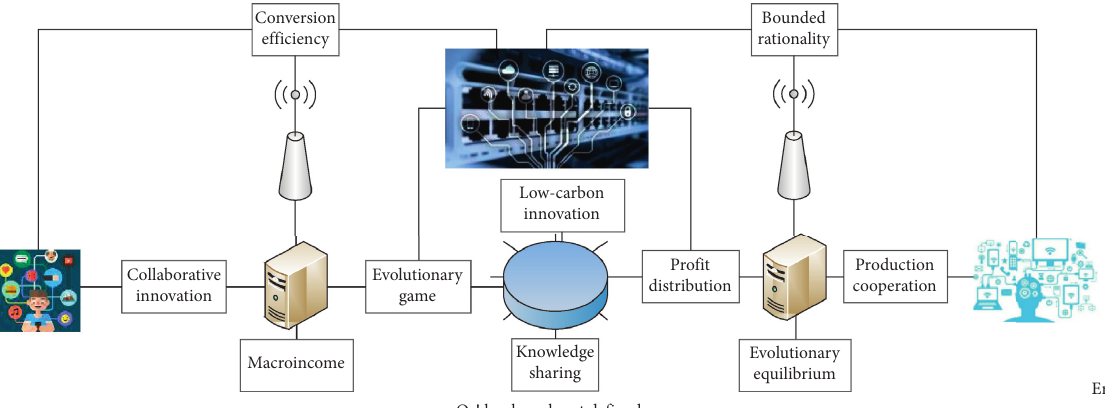
Figure 1: Hierarchical distribution of evolutionary